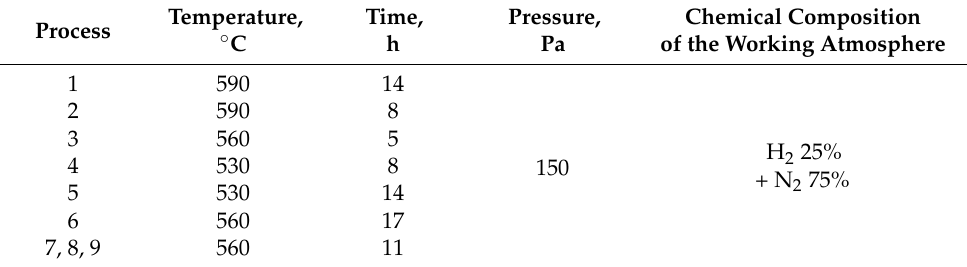
Table 2. Parameters of nitriding processes of Grade 5 titanium alloy.